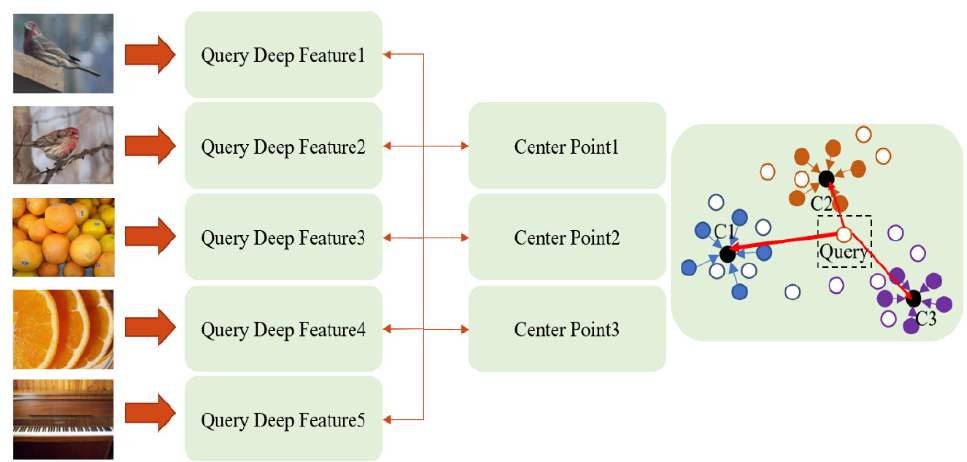
Figure 12. Query set deep feature extraction process.